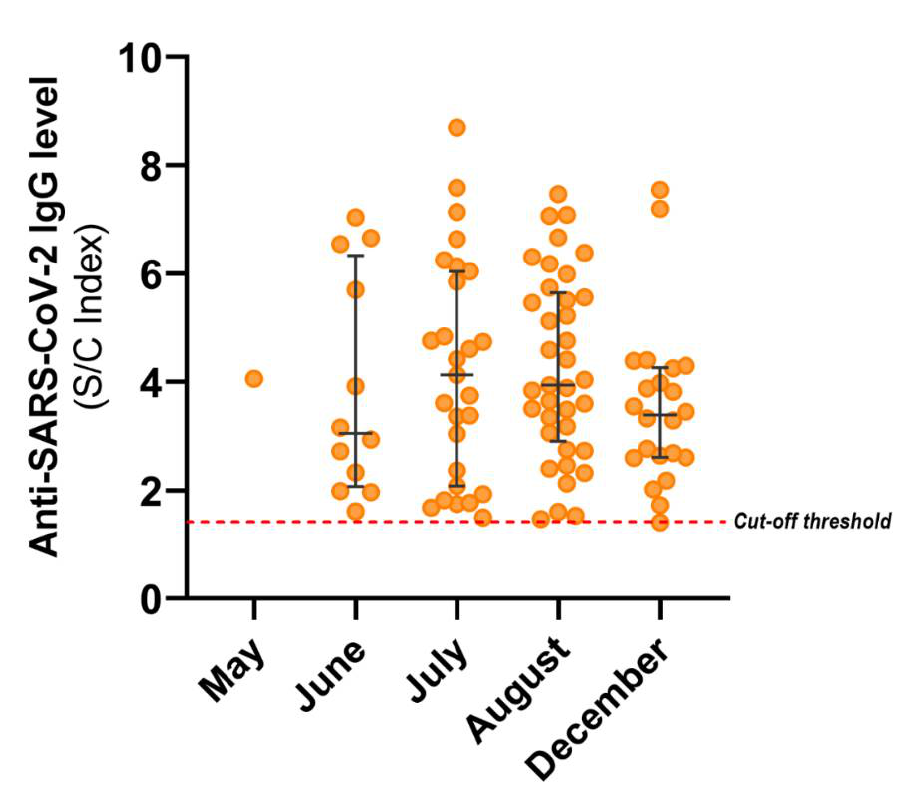
Figure 3. Anti-SARS-CoV-2 IgG titers across the collection period. S/C index values for the 99 reactive samples are graphed per month. Median and IQR are shown. Variation of antibody titers was not